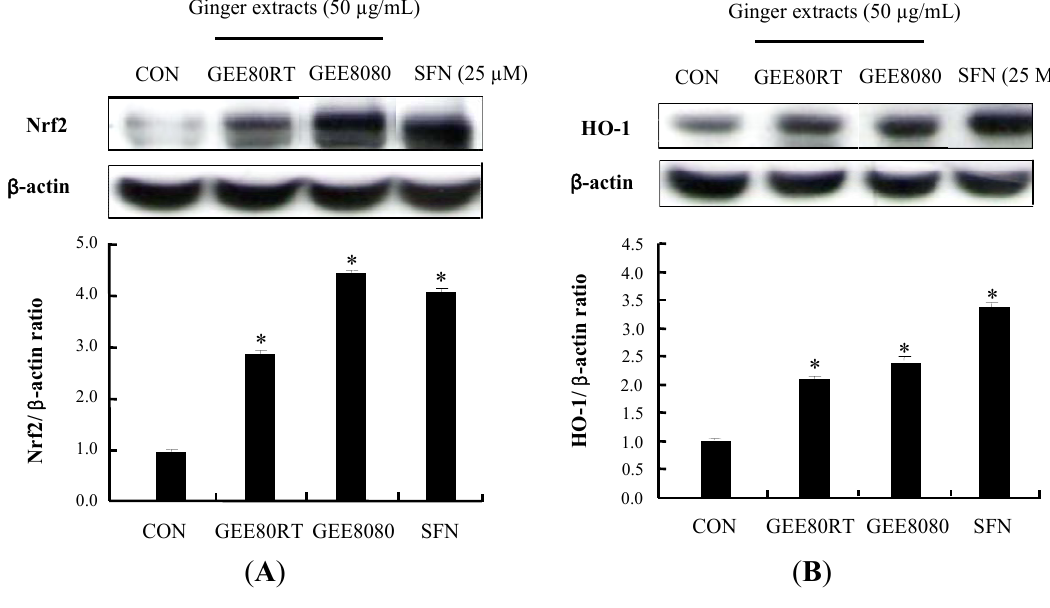
Figure 4. Effects of ginger extracts on Nrf2 and HO-1 protein expression. ( A ) Nrf2 expression levels after treatments with ginger extracts. HepG2 cells were treated with 50 µg/mL for 2 h; ( B ) HO-1 expression levels after treatments with ginger extracts. HepG2 cells were treated with 50 µg/mL ginger extracts for 24 h. Induction fold of Nrf2 and HO-1 protein was calculated as the intensity of the treated samples relative to that of the control by densitometry. Sulforaphane (SFN) was used as a positive control. The blots shown are representative of three independent experiments with similar results. Values are means ± SD; n = 3, * p < 0.05 vs .